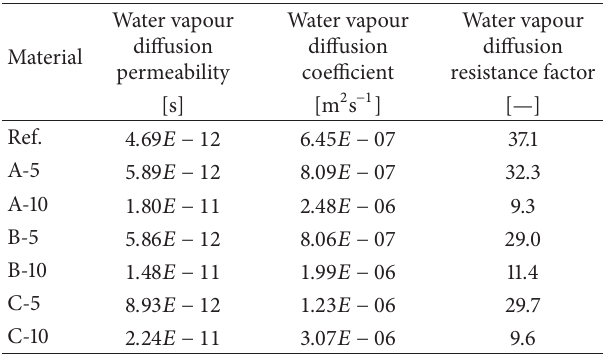
Table 9: Water vapour transport parameters: wet-cup arrangement.